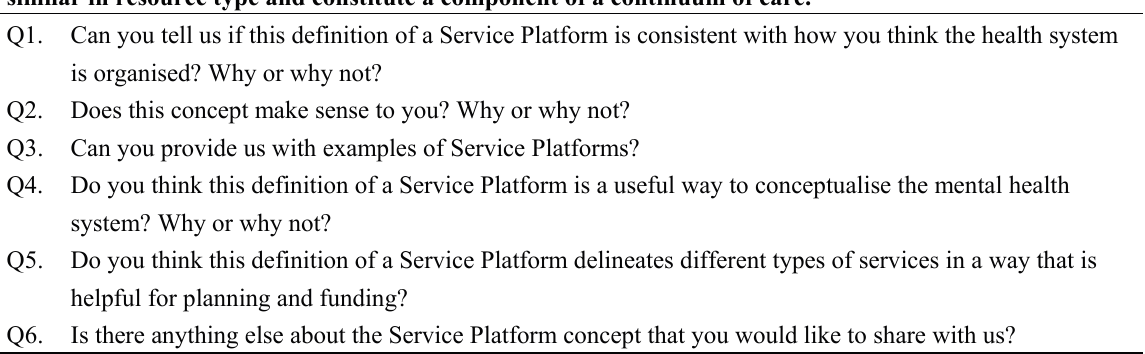
Table 1. Service Platform